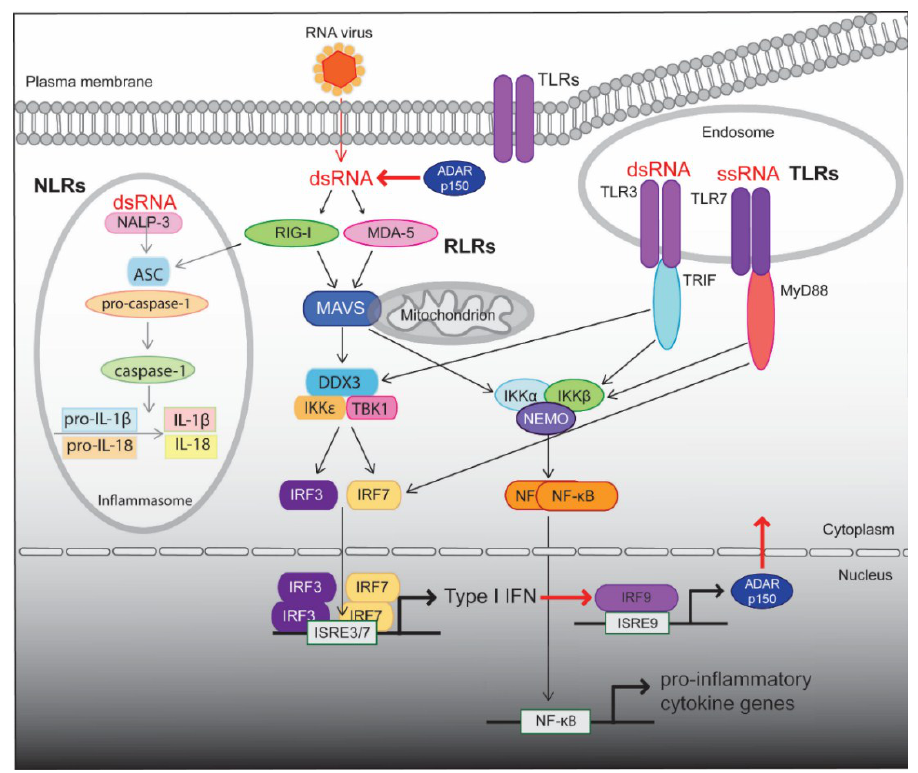
Figure 3. Intracellular detection of viral RNA by PRRs and activation of the innate immune response. The three classes of PRRs responsible for detection of viral RNA are the TLRs, the RLRs, and the NLRs. In the endosome viral ssRNA is detected by TLR7 whereas viral dsRNA is recognized by TLR3. TLR7 recruits the signaling adaptor MyD88 whereas TLR3 associates TRIF. MyD88 elicits the production of type I IFNs through the direct activation of IRF7. TRIF activates the TRAF family member-associated TANK and IKKε both of which undergo phosphorylation to activate both IRF3 and IRF7. Both IRF3 and IRF7 form homodimers which translocate to the nucleus leading to the induction of type I IFN. At the same time, both TRIF and MyD88 activate IKK. The IKK complex triggers the release and translocation of NF-κB to the nucleus leading to the production of pro-inflammatory cytokines. In the cytoplasm, short dsRNA with 5'triphospahte ends is detected by RIG-I and long dsRNA is sensed by MDA5. Activation of RIG-I and MDA5 results in the recruitment of MAVS via CARD domain interactions. MAVS dependent signaling causes the translocation of the transcription factors IRF3 and NF-κB for the induction of type I IFN and pro-inflammatory cytokines respectively. The inflammasome is activated by dsRNA via NALP3-dependent signaling pathway. NALP3 together with ASC recruit pro-caspase-1 which in turn undergoes auto-cleavage to produce caspase-1. Activation of caspase-1 is required for the cleavage of pro-IL-1β and pro-IL-18, and subsequent secretion of the proinflammatory cytokines IL-1β and IL-18, respectively. ADAR1p150 edits dsRNA within the cytoplasm and is induced by